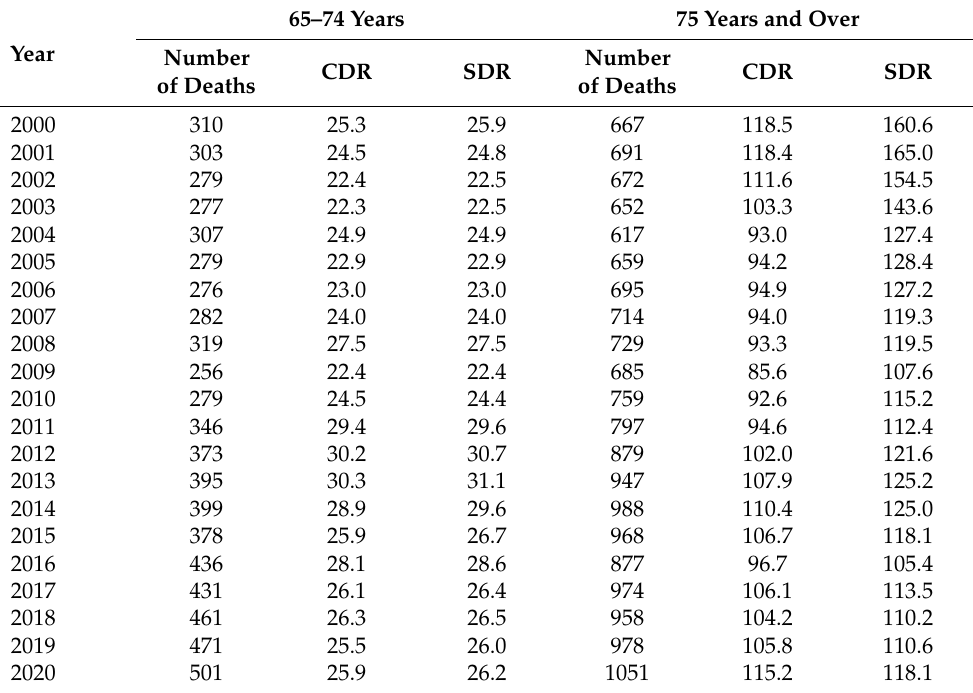
Table 1. Number of deaths, crude death rates (CDRs), and standardized death rates (SDRs) due to falls in men aged 65–74 years and 75 years and over in Poland in